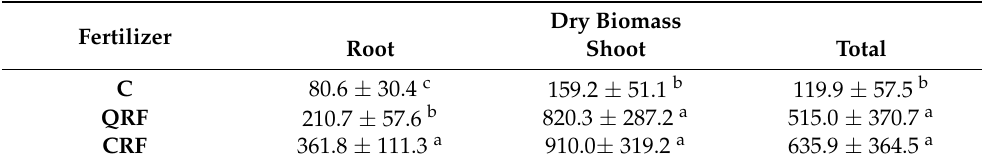
Table 1. Effect of substrates (P: peat; PP: peat with perlite; PV: peat with vermiculite; PPV: peat with Table 2. Effect of the type of fertilization (C: control treatment; QRF: quick-release fertilizer; CRF: perlite and vermiculite—without distinguishing between fertilizers); and the effect of controlled- controlled-release fertilizer) on the biomass of the acclimatized plants. Each value is the average ± SE release (CRF) and quick-release (QRF) fertilizers (without distinguishing between substrates), on (standard error) of 120 records taken in 8 plants, for 3 days, during the last 2–3 weeks of the acclimati- zation period. average ± SE (standard error) of 120 records taken in 8 plants, 3 days each, during the last 2–3 weeks of the acclimatization period.